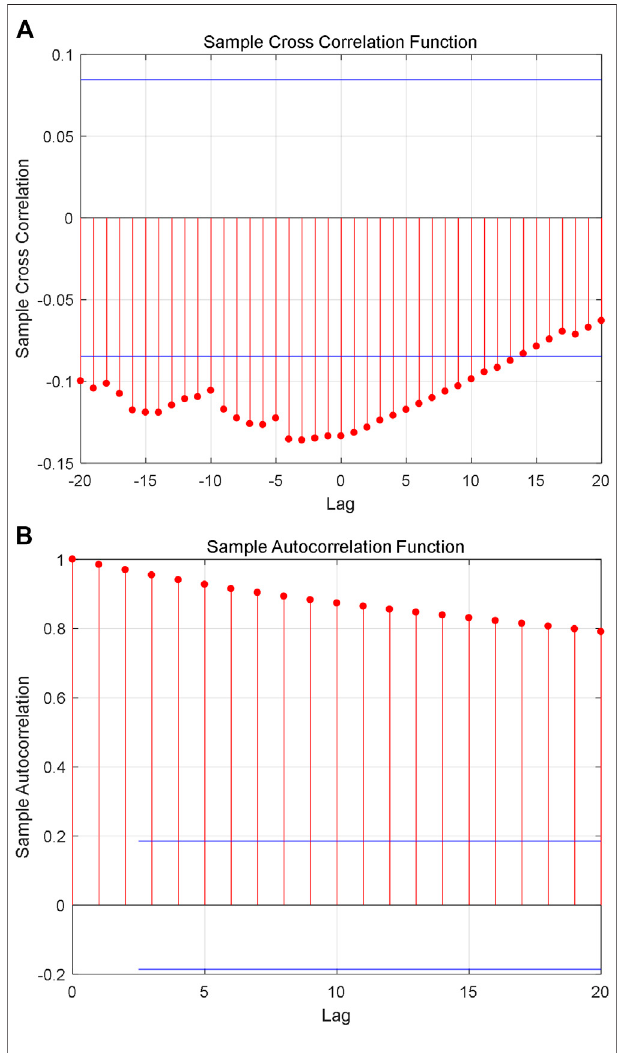
FIGURE 8 | Correlation analysis of the fi rst group time series. (A) Cross- correlation with the natural logarithm of coding value of AAS. (B) Autocorrelation of sorting natural logarithm of AHTPA-EC 50